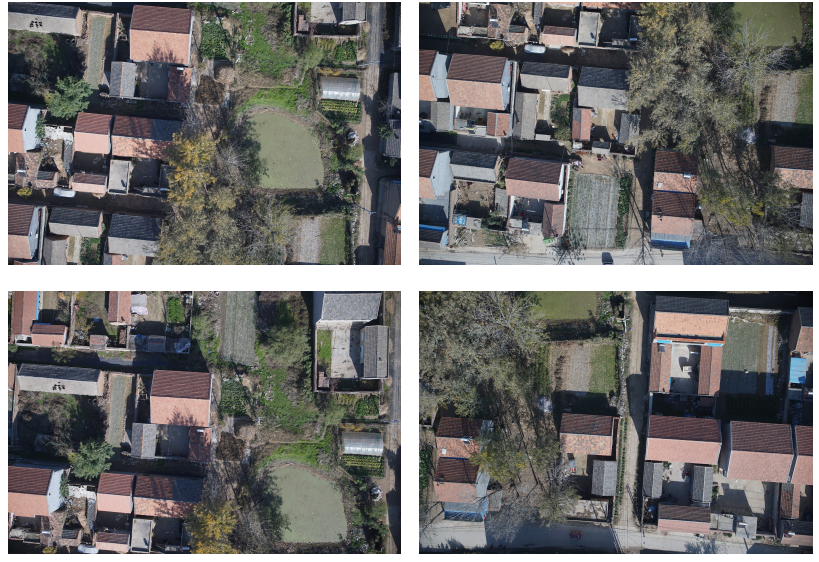
Figure 11. Some of the aerial images were used to generate the digital orthophoto of a village.